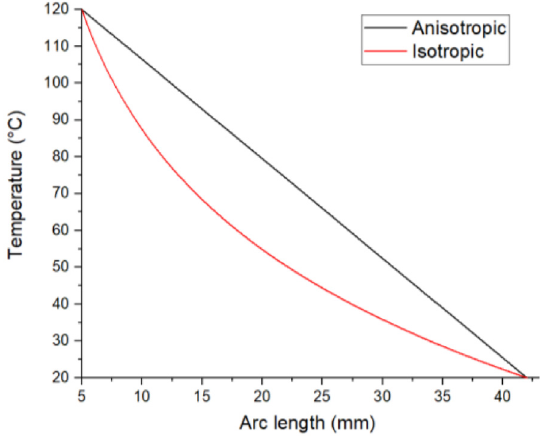
Fig. 3. Temperature gradient for the theoretical ideal anisotropic diffuser (black) and a conventional isotropic copper diffuser